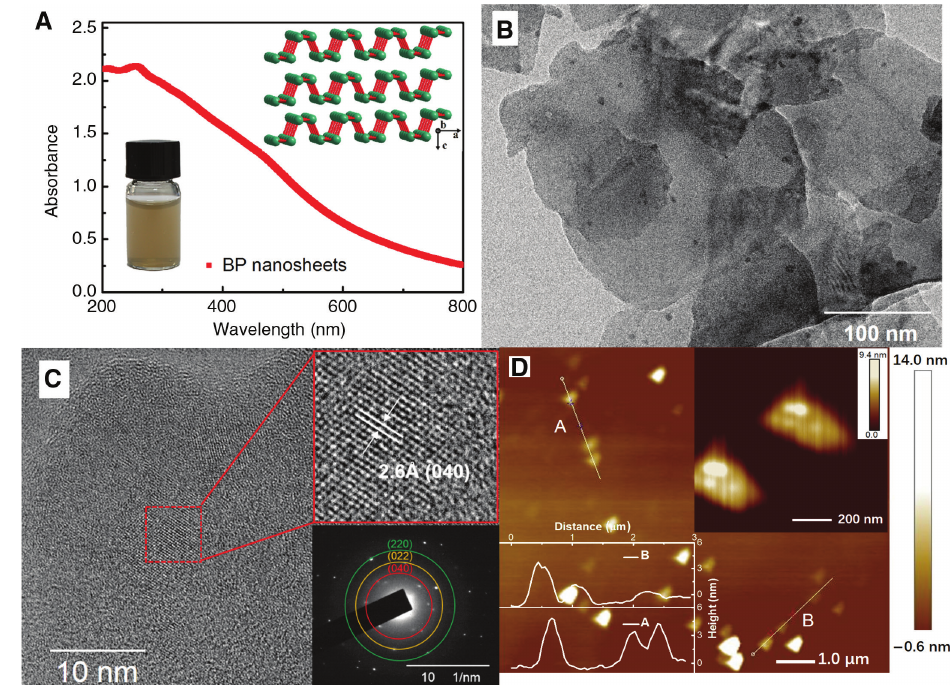
Figure 1: Absorbance spectrum and structural characterizations of black phosphorus (BP) nanosheets. (A) Absorbance spectrum of black phosphorus (BP) nanosheets. The upper inset is the schematic lattice structure of multilayer BP and the inset at the bottom is the picture for the aqueous solution of BP nanosheets. (B) Transmission electron microscopy (TEM) images of the BP nanosheets. (C) High-resolution TEM image. The insets are schematic illustration of the atomic arrangements and the corresponding selective area electron diffraction (SAED) pattern. (D) Atomic force microscopy image of BP